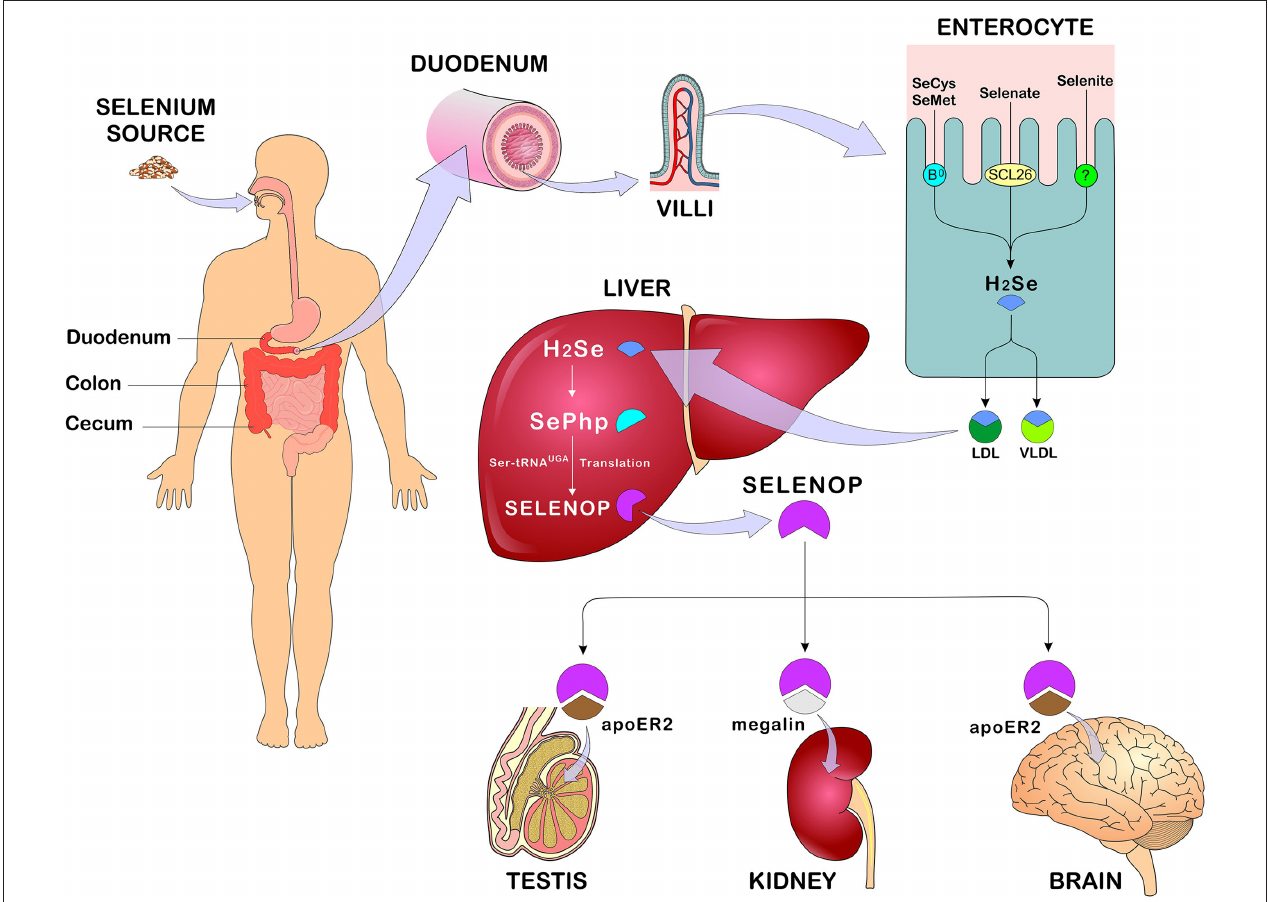
FIGURE 3 | Se absorption, metabolism, and distribution. After eating Se-rich foods in its organic and/or inorganic form, Se absorption occurs in the duodenum, cecum, and colon. In enterocytes, SeMet and SeCys are absorbed by active transport (systems B0 and b0 + rBAT) while selenate is absorbed by passive transport (anion changers of the SLC26 gene family). After absorption, all forms of Se are converted to H 2 Se through reactions that occur in the enterocyte and transported in the blood bound LDL, VLDL (mainly). In the liver, H 2 Se is converted to SePhp and incorporated into selenoproteins in the form of SeCys. Transport to other tissues such as testis, kidneys, and brain occurs mainly in the form of SELENOP through receptor-mediated endocytosis - apoE2 and megaline. Se, selenium; SeMet, selenomethionine; SeCys, selenocysteine; H 2 Se, hydrogen selenide; LDL, low-density lipoprotein; VLDL, Very low-density lipoprotein; SePhp, selenophosphate; SELENOP, selenoprotein P; apoE2, apolipoprotein E receptor 2 (Figure illustration by Francisco Irochima